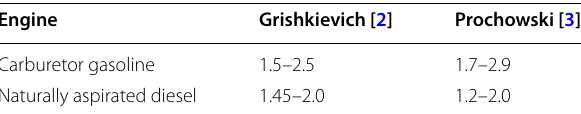
Table 2 Values of the coefficients of flexibility for